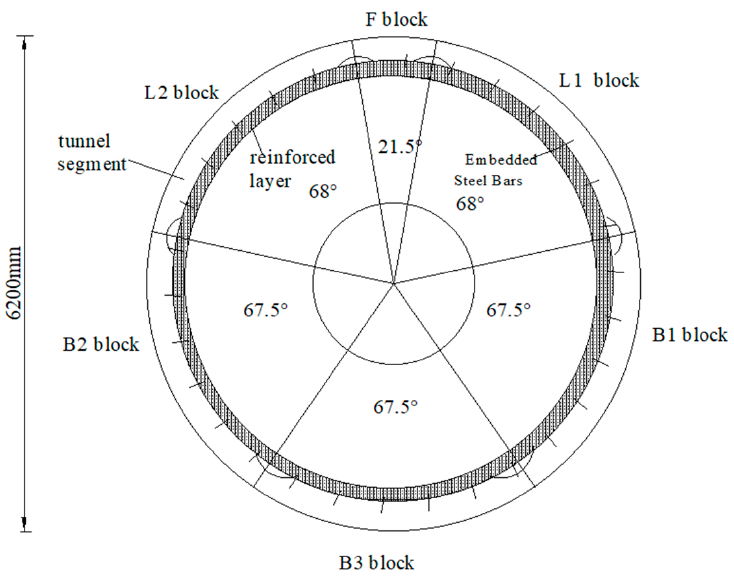
Figure 4. Indication diagram of tunnel lining segment structure strengthened by in situ spraying